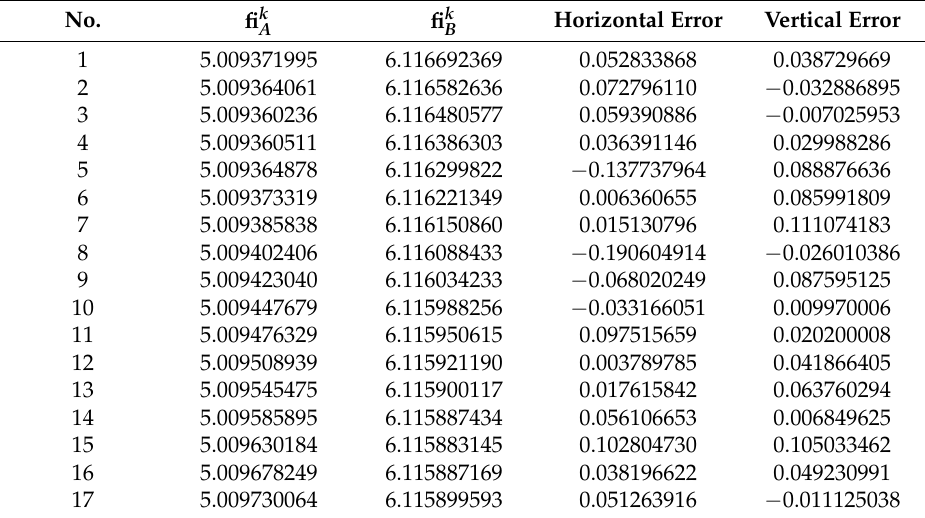
Table 4. Azimuth angles and positioning errors in the turning of improved